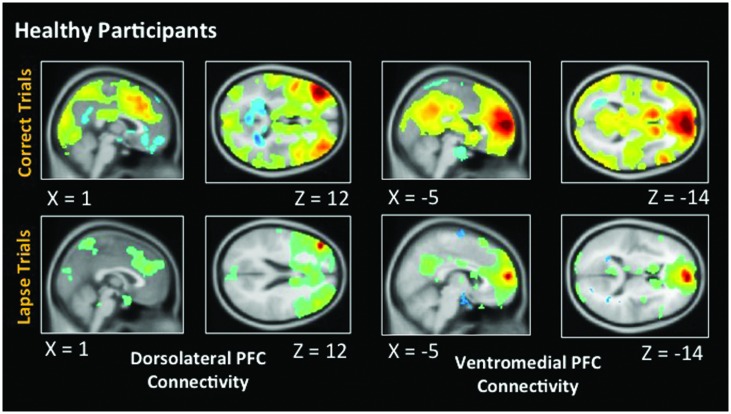
Connectivity results for healthy participants. Positive correlations are shown in hot colors. Anticorrelations are shown in cool colors. Dorsolateral PFC indicates voxels which significantly correlated with a 5 mm seed located at (-42, 45, 21). Ventromedial PFC indicates voxels which significantly correlated with a 5 mm seed located at (2, 61, 13). Voxel-wise threshold p < 0.01, FWE corrected p < 0.05 at the cluster level. Right-sided seeds yielded similar results.